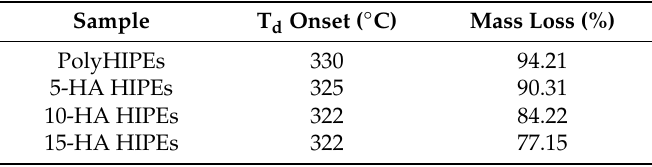
Table 1. Thermal properties of poly(TT / DPEHA / HA)HIPEs by thermogravimetric analysis.